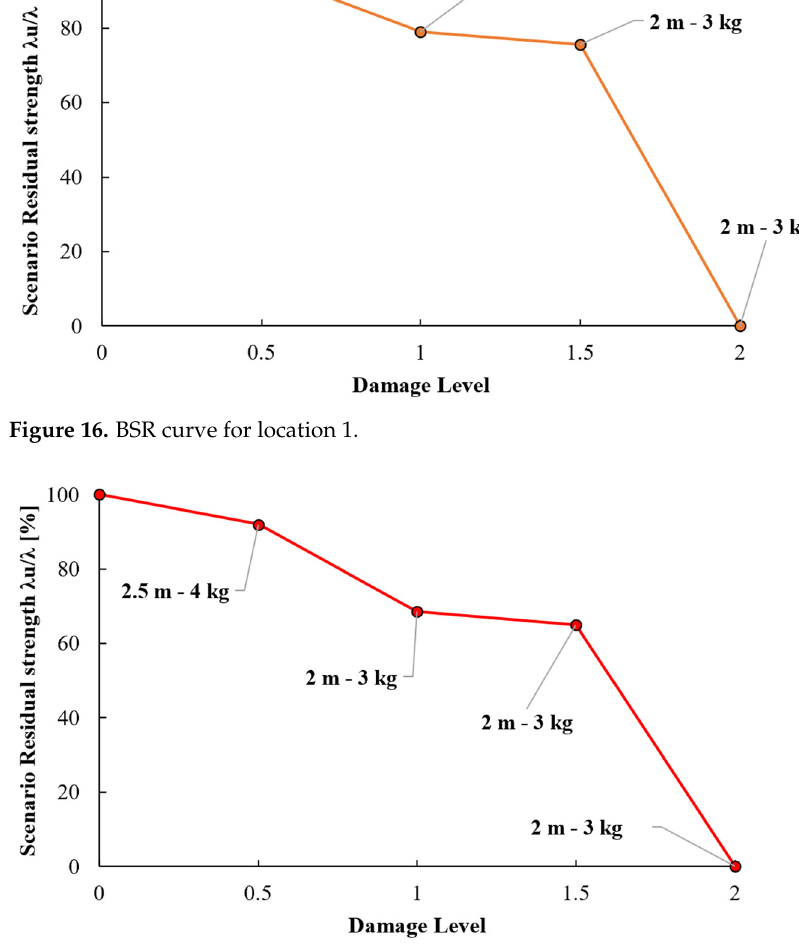
Figure 17. BSR curve for location 2.